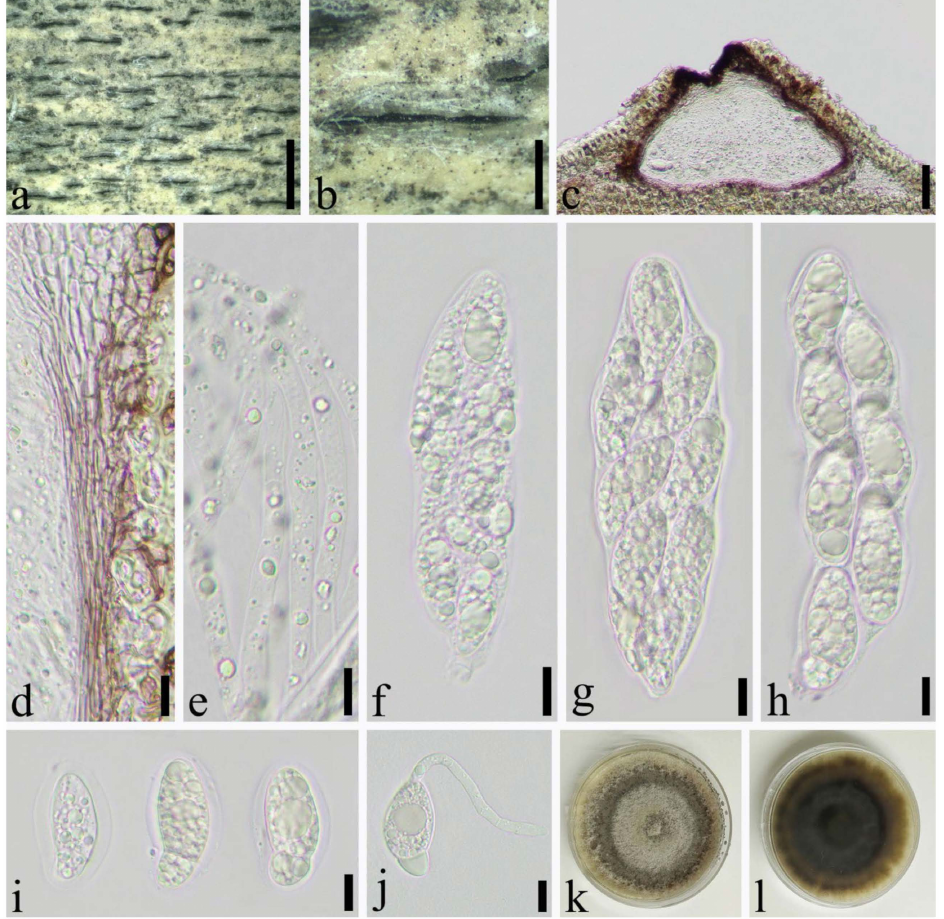
Figure 7. Apiospora neosubglobosa (SICAU 22-0071). ( a , b ) Ascostromata developing on bamboo culm. ( c ) Vertical sections of ascostromata. ( d ) Peridium. ( e ) Paraphyses. ( f – h ) Asci. ( i ) Ascospores. ( j ) Germinating ascospore. ( k , l ) Cultures on PDA. Scale bars: ( a ) = 2 mm, ( b ) = 500 µ m, ( c ) = 50 µ m, ( d – j ) = 10 µ